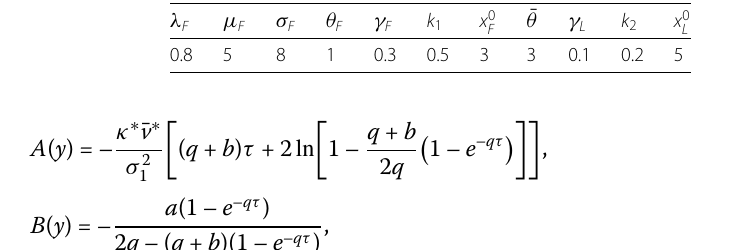
Table 3 The values of the financial market parameters T τ r 0 η κ ¯ v σ 1 ρ ξ 0.05 5 (0.13) 2 0.25 –0.4 –6 0.15 2 Table 4 The values of the insurer’s and the reinsurer’s parameters λ F μ F σ F θ F γ F k 1 x 0 0.8 5 8 1 0.3 0.5 3 3 0.1